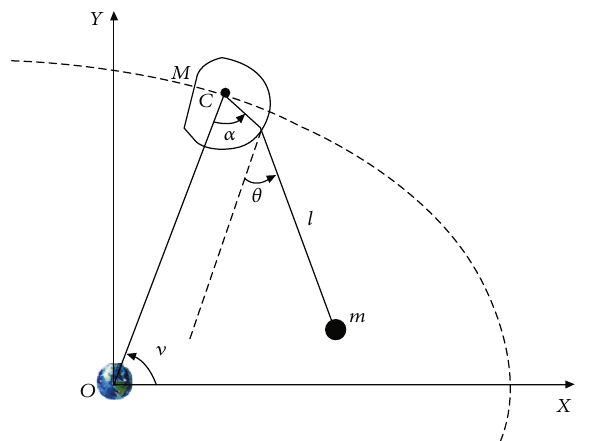
Figure 1: Schematic view of the in-plane tethered satellite